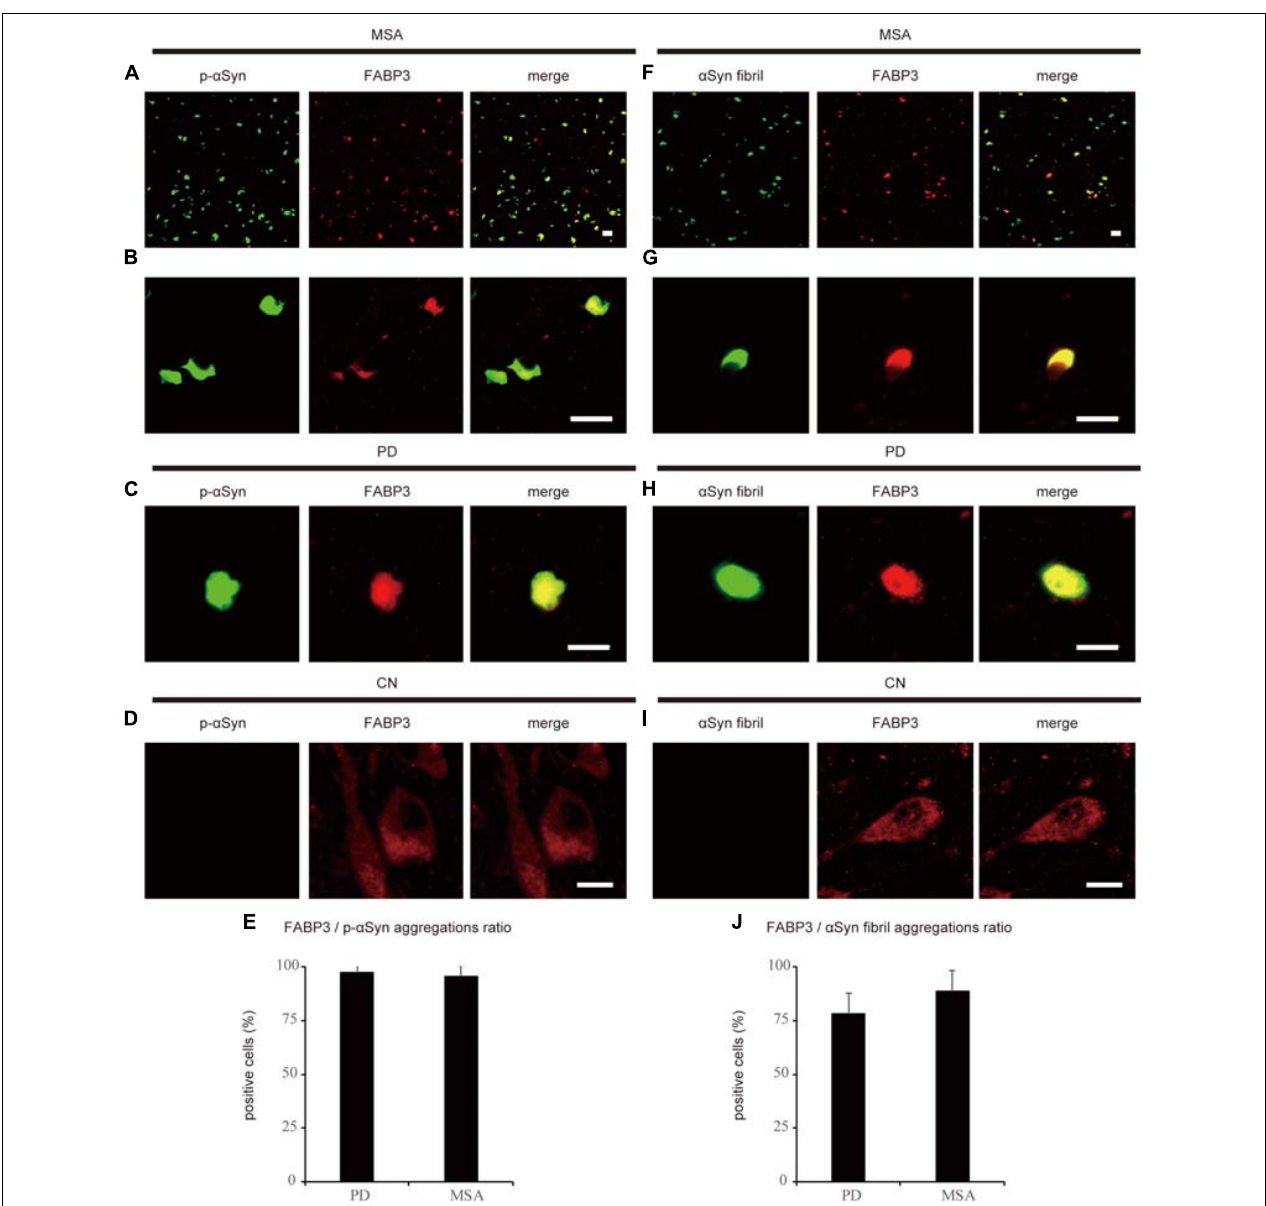
FIGURE 2 | Correlation between FABP3 protein accumulation and α Syn aggregation in synucleinopathies. IF staining of FABP3 (red) and p- α Syn (green) in the SN in MSA tissue is shown in low-magnification (A) and high-magnification (B) images; staining in the SN in PD tissue is shown in low-magnification images (C) ; and staining in the SN in CN tissue is shown in high-magnification images (D) . (A–C) shows that FABP3 was colocalized with p- α Syn aggregates in synucleinopathies. In contrast, (D) shows that p- α Syn aggregates were not observed in the SN in CNs, although FABP3 protein was detected in DA neurons. The ratio of FABP3 protein accumulations to p- α Syn aggregates in the striatum in MSA tissue and in the EC in PD tissue was quantitatively analyzed (E) ( p = 0.666). (E) shows that FABP3 accumulations were colocalized with most p- α Syn aggregates in both PD and MSA tissues. IF staining of FABP3 (red) and α Syn fibrils (green) in the SN in MSA tissue is shown in low-magnification (F) and high-magnification (G) images; staining in the SN in PD tissue is shown in low-magnification images (H) ; and staining in the SN in CN tissue is shown in high-magnification images (I) . (F–H) shows that FABP3 accumulations were colocalized with α Syn fibrils in synucleinopathies. In contrast, (I) shows that α Syn fibrils were not observed in the SN in CNs, although FABP3 protein was detected in DA neurons. The ratio of FABP3 protein accumulations to α Syn fibrils in the striatum in MSA tissue and in the EC in PD tissue was quantitatively analyzed (J) ( p = 0.119). (J) shows that FABP3 accumulations were colocalized with approximately 80% of α Syn fibrils in both PD and MSA tissues. Scale bars = 20 µ m.